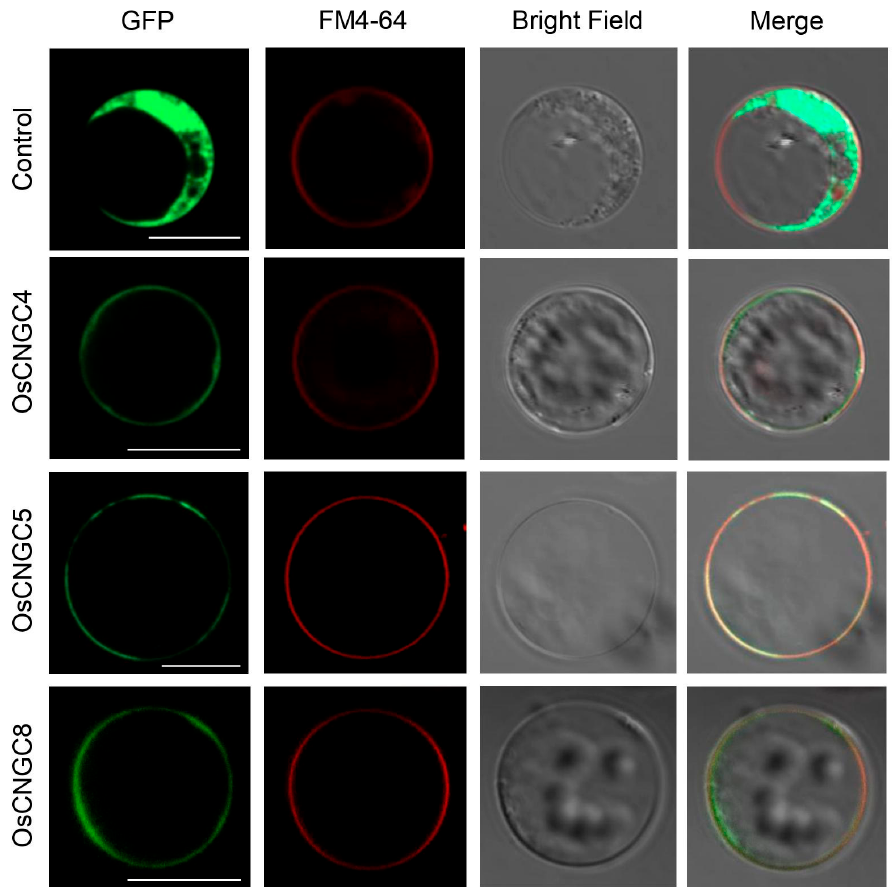
Figure 5. Three pollen-preferential expressed OsCNGC-green fluorescence protein (GFP) signals were observed in plasma membrane in rice protoplast. The second panel shows the membrane marker through FM4-64 staining, the third panel shows the bright-field image, and the last panel shows merged images of GFP and FM4-64. The red signal shows the membrane, the green signal shows OsCNGC localization, and the yellow signal shows merged images from the OsCNGC localization and PM signal. Scale bar = 20 μ m. Experiments were repeated three times with similar re- sults.